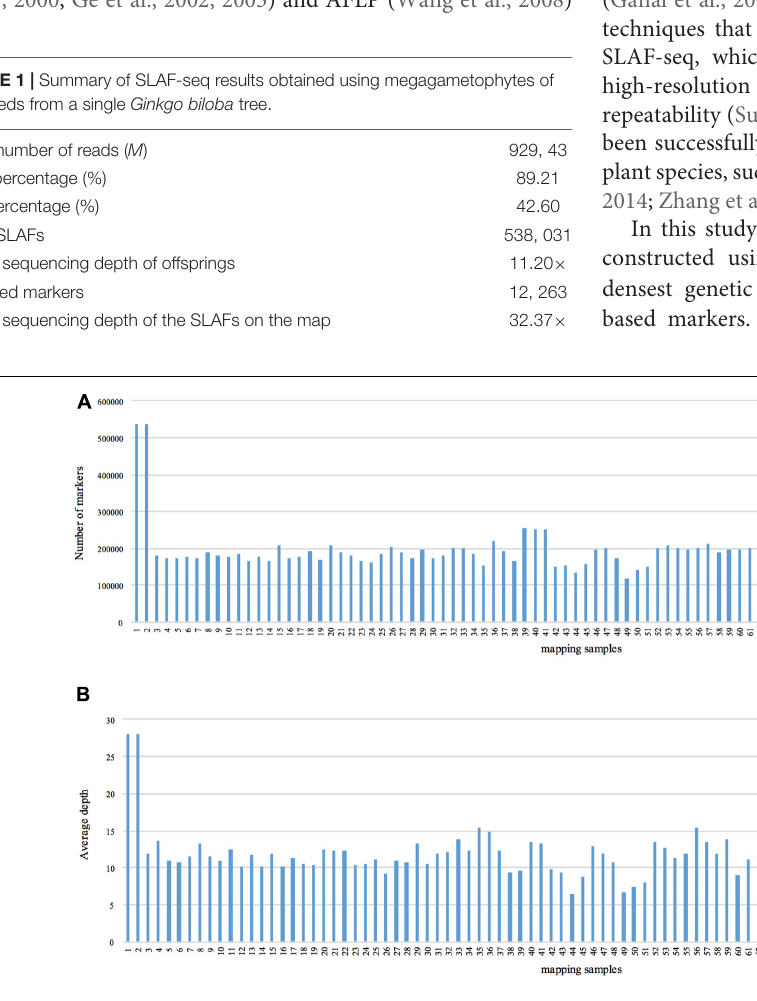
FIGURE 1 | Number of markers and average sequencing depth of each progeny. The x -axes in (A,B) indicate the identity of the mapping samples, and the y -axes indicate the number of markers (A) and average depth (B) .